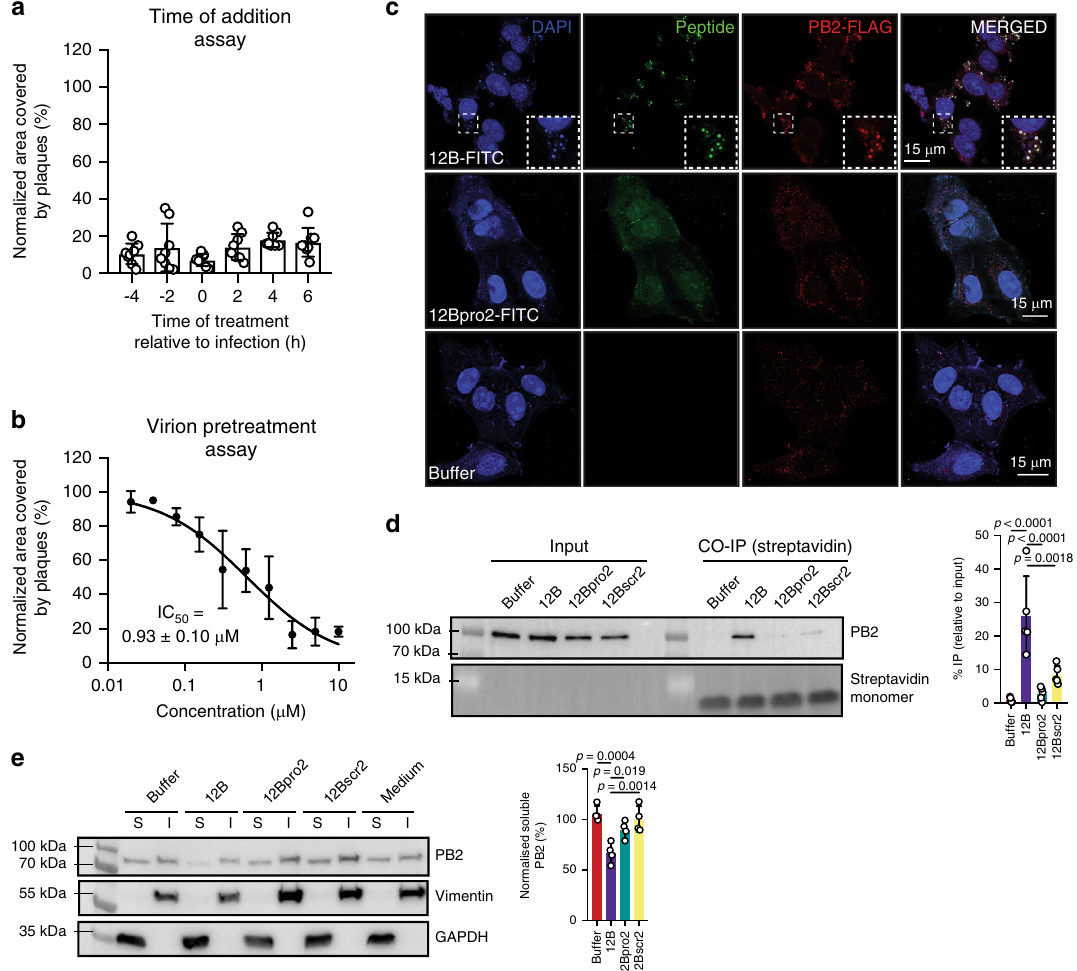
Fig. 4 Amyloid peptide 12B interacts with in fl uenza via the PB2 target protein in cellulo. a Quanti fi cation of the area covered by plaques of A/PR8- infected MDCK cells treated with 10 µ M peptide 12B at different time points relative to infection. Data are normalized to medium-treated cells and mean ± SD is shown ( n = 8 from three independent experiments, statistics: one-way ANOVA with multiple comparison, p value = 0.0605). Representative images are shown in Supplementary Fig. 5a. b Quanti fi cation of the area covered by plaques in a plaque-size reduction assay of MDCK cells infected with A/PR8 virion particles that were pretreated with peptide 12B. Concentration-dependent effect of peptide 12B is shown normalized to medium-treated virion particles as mean ± SD ( n = 3 independent experiments). Representative images are shown in Supplementary Fig. 5b. c MDCK cells treated with FITC- labeled peptide 12B, 12Bpro2 (10 µ M), or buffer for 2 h prior to A/WSN-FLAG infection (MOI = 1, 16-h infection). Cells were fi xed and stained with an anti- FLAG antibody and DAPI. One representative example of three independent experiments. d Western blot analysis of total (input) and immunoprecipitated fraction of MDCK cells treated with PEG 2 -biotin-labeled peptide (10 µ M) or buffer for 2 h prior to A/WSN-FLAG infection (MOI = 1, 16-h infection). Quanti fi cation of immunoprecipitated fraction of PB2, relative to PB2 input levels, is shown on the right. Data represent mean ± SD ( n = 5 independent experiments, statistics: one-way ANOVA with multiple comparison). Streptavidin was used as a loading control. e Western blot analysis of PB2 distribution in soluble and insoluble fraction of lysates of MDCK cells treated with peptide (10 µ M) for 2 h prior to in fl uenza A/WSN-FLAG infection (MOI = 1, 16-h infection). Vimentin and GAPDH were used as loading controls for insoluble and soluble fraction, respectively. Quanti fi cation represents soluble PB2 fraction, normalized to medium-treated cells (100% soluble PB2). Data represent mean ± SD ( n = 4 independent experiments, statistics: one-way ANOVA with multiple comparison). For d and e the samples on one blot are derived from the same experiment and the gels/blots were processed in parallel. Full blots are shown in Supplementary Fig.